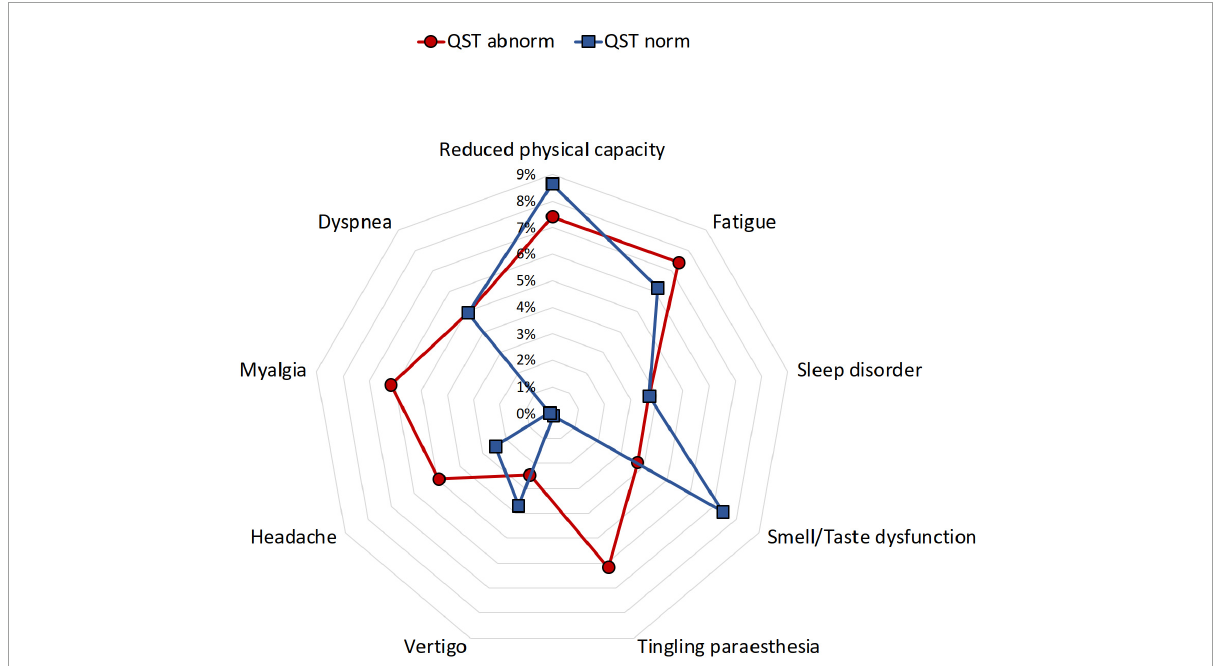
FIGURE4 Distribution of frequent post-COVID complaints in children and adolescents with and without abnormal QST. QST, quantitative sensory testing. Normal QST (blue), abnormal QST